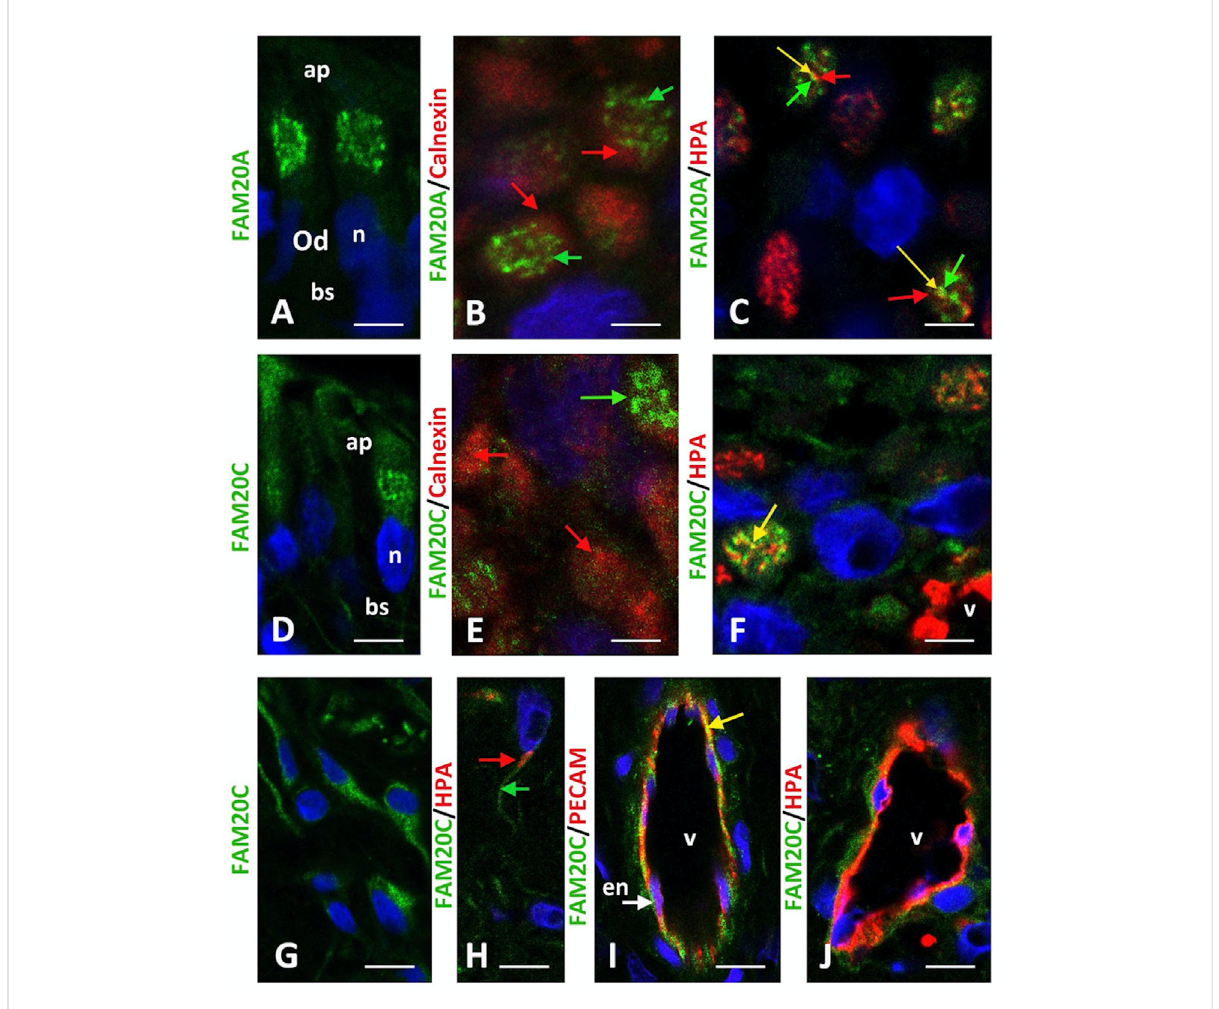
FIGURE 6 FAM20A and FAM20C immunostaining in permanent teeth. (A) In the polarized secretory odontoblast (Od) FAM20A localized to a large structureintheapical domain(ap). (B) The mergedimageindicated thattheendoplasmicreticulum marker,Calnexin (redarrows), didnot colocalize withFAM20A(greenarrows). (C) Helixpomatiaagglutinin (HPA,red),aspeci fi cmarkerofthecis-andmedial-Golgicompartmentscolocalizedpartly with FAM20A (green) at the interface with the trans-Golgi compartment (yellow arrows). (D) FAM20C localized to a large structure in the apical domain of the polarized odontoblast. Scattered vesicles were also found along the cytoplasm and to some extent in the basal domain at the level of the primary cilium (bs, arrow). (E) The merged image indicated that the endoplasmic reticulum marker, Calnexin (red arrow), did not colocalize with FAM20C (green arrow). (F) HPA and FAM20C colocalized partly at the interface between the medial- and trans-Golgi compartments (yellow arrow). (G,H) In pulp fusiform fi broblasts, FAM20C was expressed in small vesicles (G) that did not express HPA (H) . (I) FAM20C was expressed in endothelial PECAM-positive cells (yellow arrow) at the interface of the HPA-positive compartment (J) . Scale bars: (A,D,G,H) = 30 μ m. (B,C,E,F) = 10 μ m. (I,J) = 60 μ m. en, endothelial cell; n,